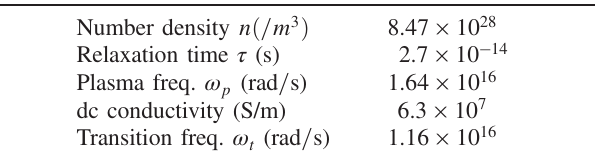
TABLE I. Free electron properties of copper. The electron densities are taken from Table 1.1 and the relaxation times from Table 1.3 in Ref.